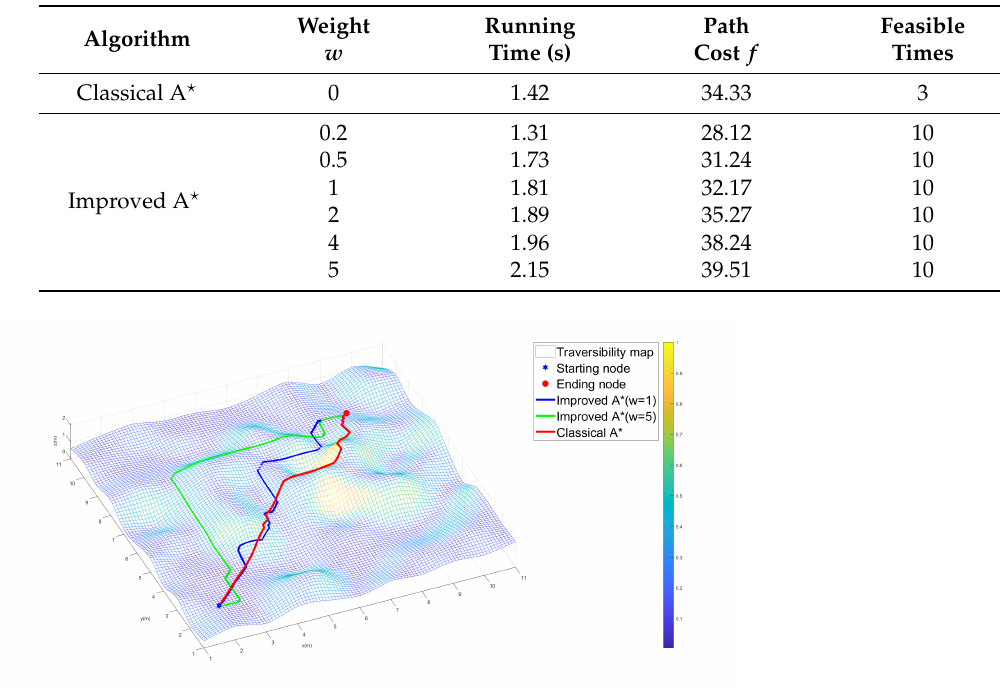
Table 1. The algorithms’ average performance on global path planning in the 10 test scenarios.